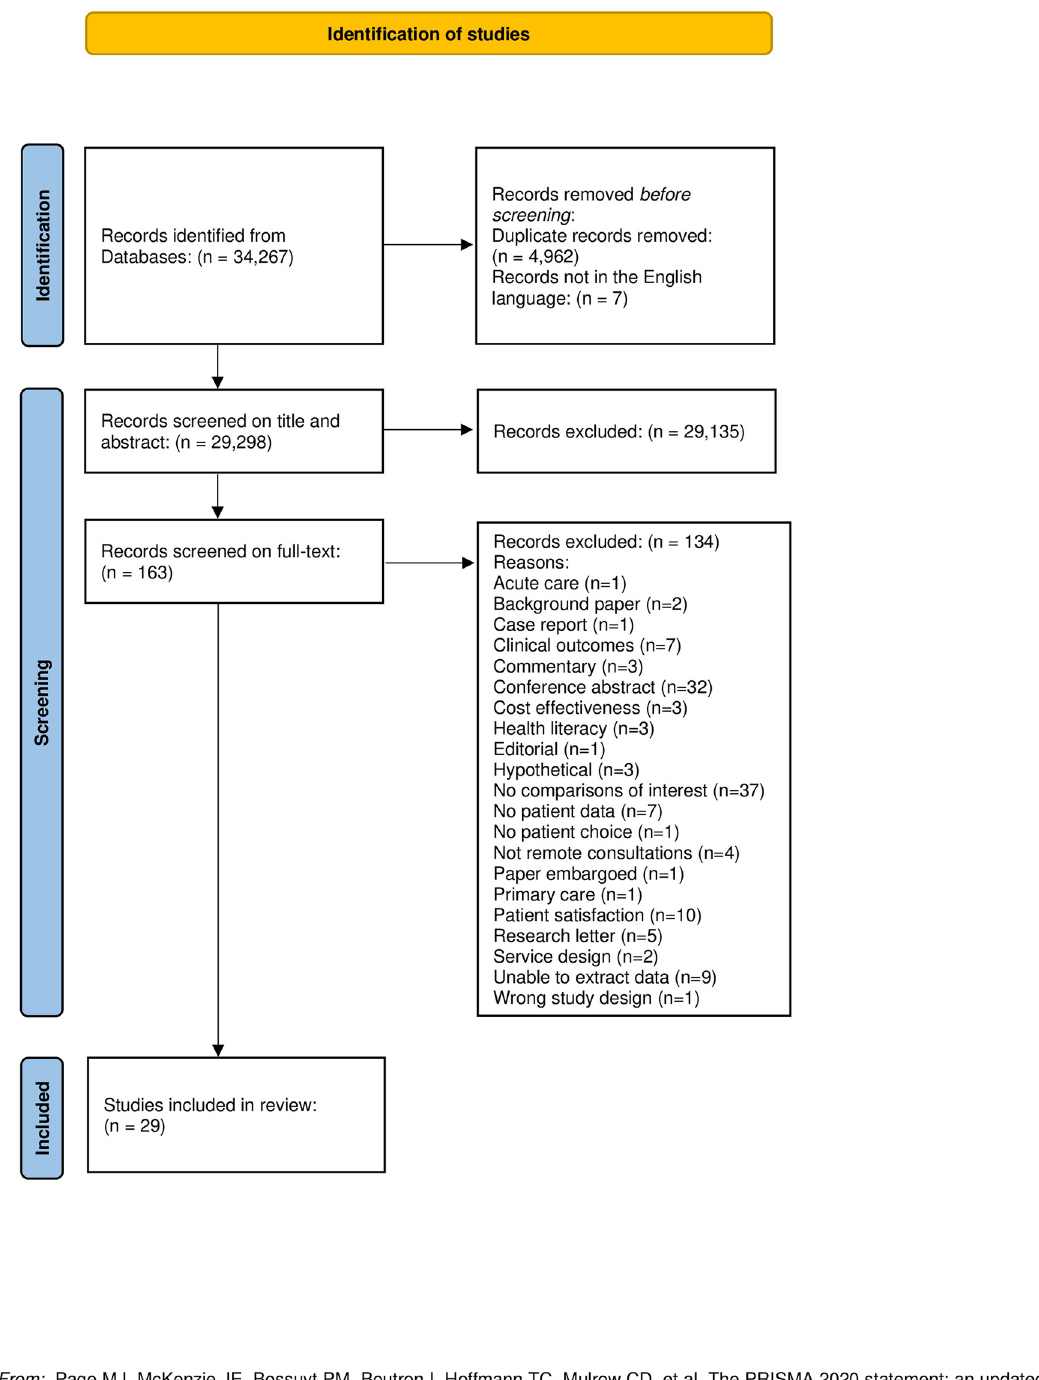
Fig 1. Study selection